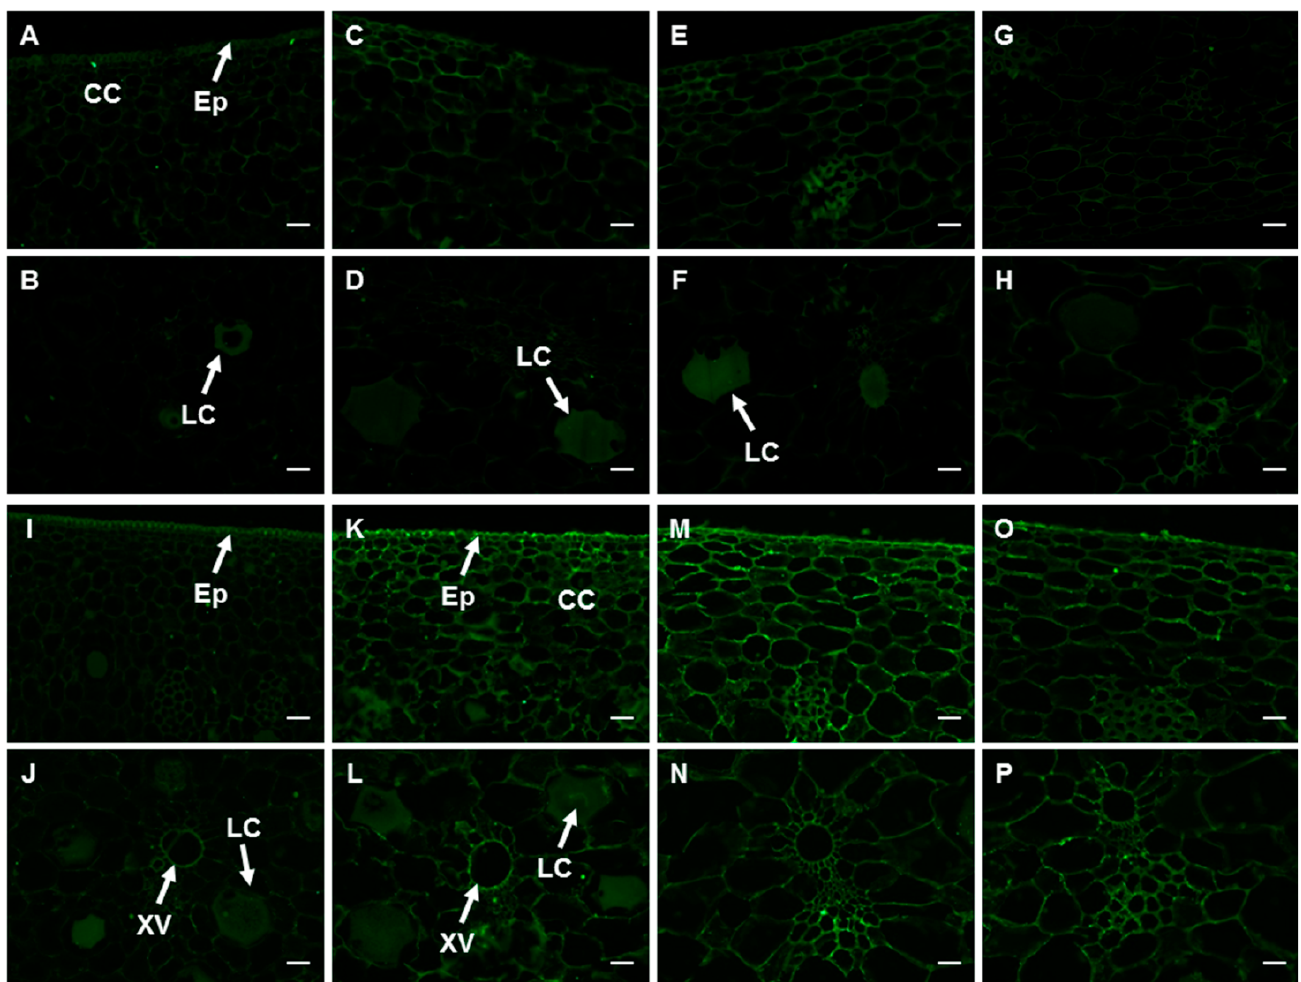
Figure 5. Spatio-temporal changes in PME ( A – H ) and the epitope of 2F4 antibody ( I – P ) in banana ( Musa spp. AAA) peel during fruit development and ripening. ( A , B , I , J ) Peel of fruits just emerging from the bunch; ( C , D , K , L ) Fruit peel at 35 d; ( E , F , M , N ) Fruit peel at 60 d; ( G , H , O , P ) Fruit peel at harvest. CC: cortex cells; Ep: epidermis; LC: latex cells; XV: xylem vessel. Bar = 50 μ